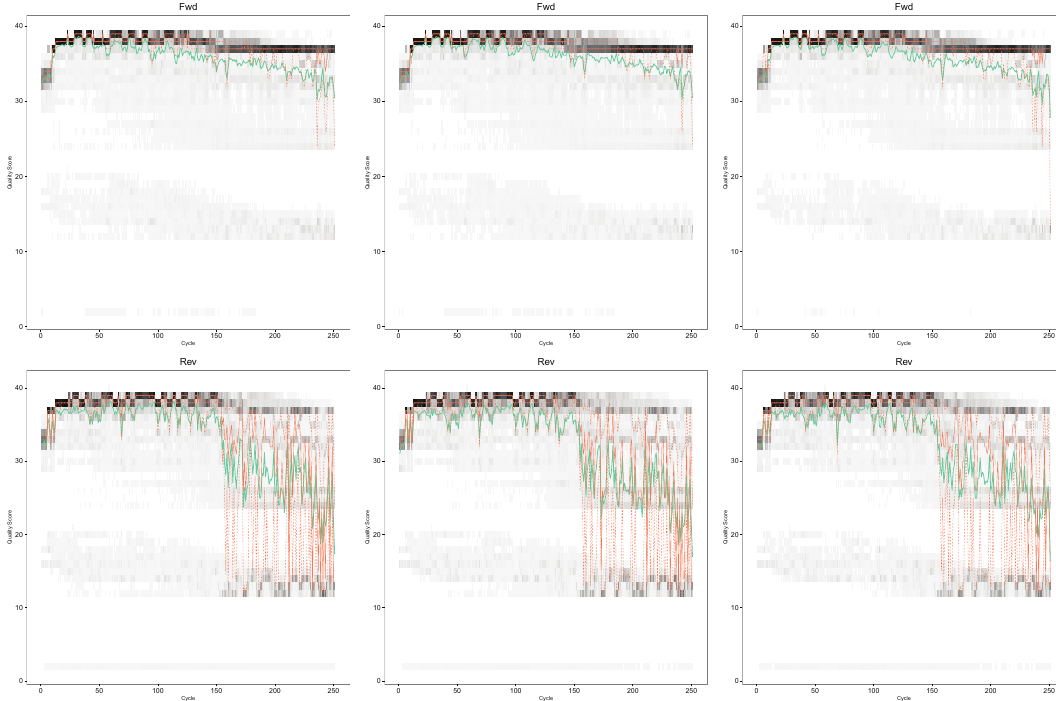
Figure 1. Forward and Reverse Error Profiles, the mean is in green, the median the solid orange line and the quartiles are the dotted orange